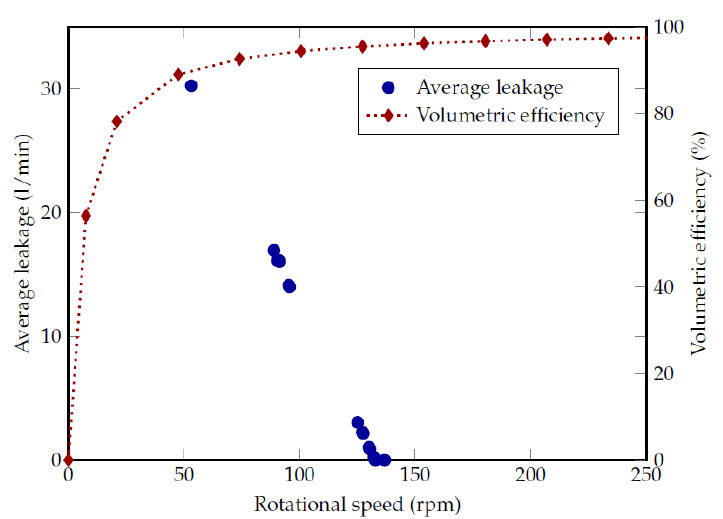
Figure 7. The effect of rotational speed on average leakage and volumetric efficiency